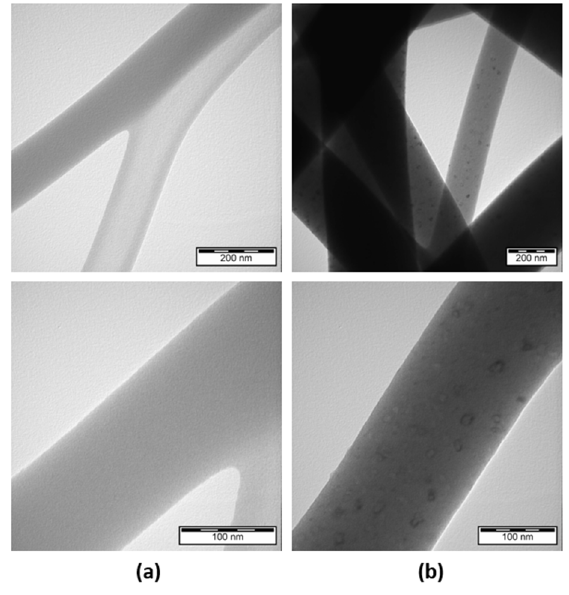
Figure 2. TEM images of electrospun silk fibroin composites with two different magnifications of 200 nm and 100 nm: ( a ) SFs; ( b ) CSFs/15%DSS.